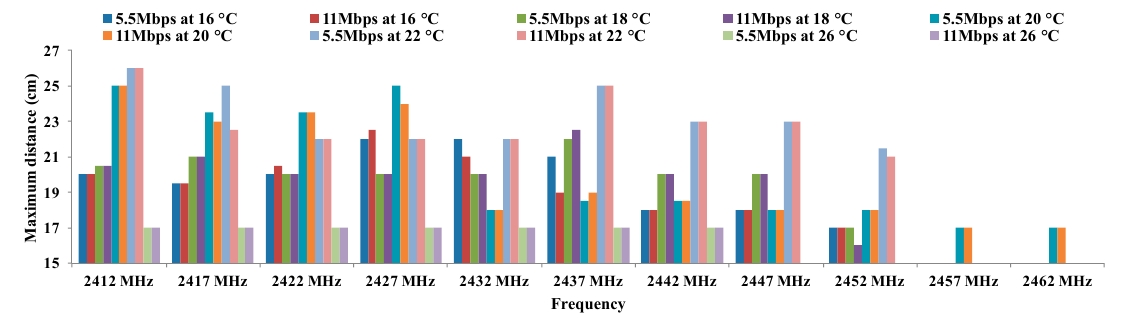
- Table 7. ANOVA for QPSK. Origin of Variations